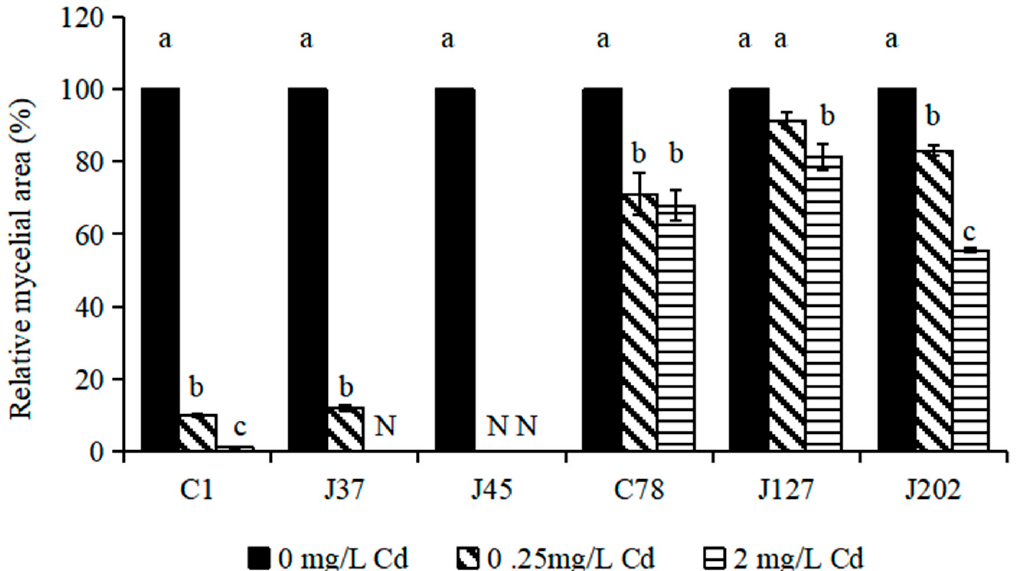
Figure 1. The relative growth of six strains of C. geophilum under different Cd concentrations. Relative mycelial area was calculated as ((mycelial area at a certain Cd concentration)/(mycelial area at 0 mg/L Cd)) × 100(%). Data were shown as mean ± SD of replicates ( n = 3). Values with different letters are significantly different (Kruskal–Wallis test, α < 0.05). N represents that the isolate did not grow.